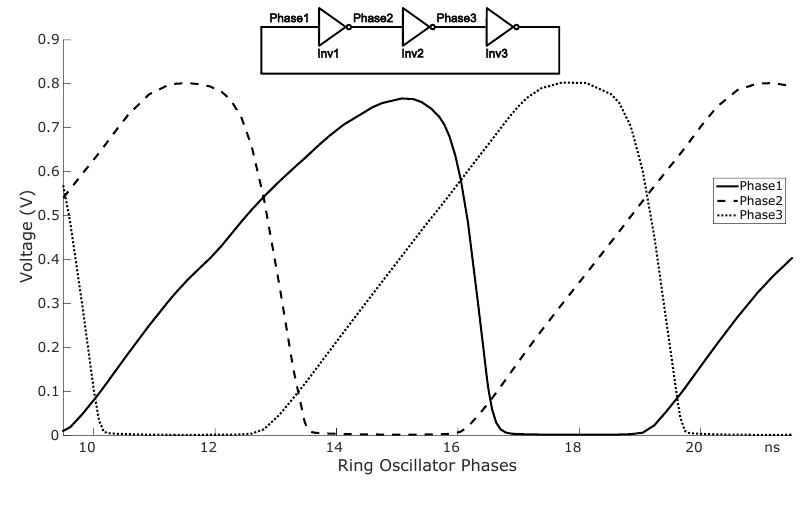
Figure 3. BiCMOS Inverter.